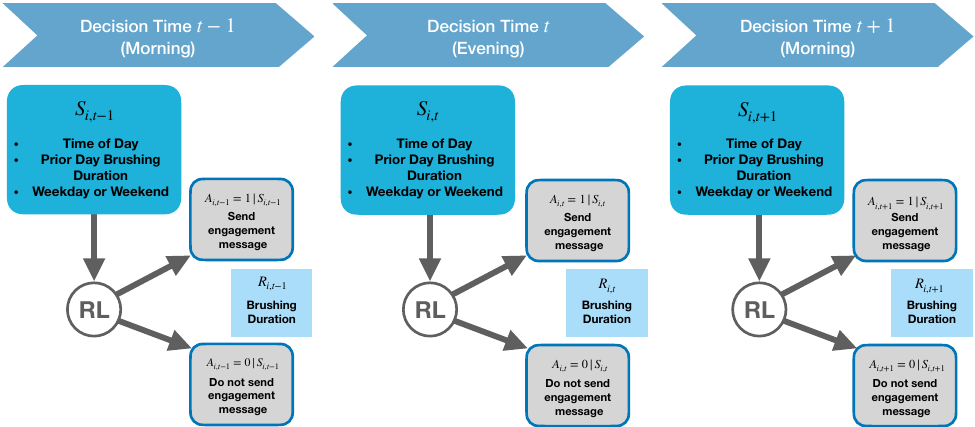
Figure 1. Decision times and actions for the RL algorithm in the Oralytics study. There will be two decision times per day (one in the morning and one in the evening); in total, each user will have 140 decision times, which we index by t . At a given decision time t , the RL algorithm receives state information for each user S i , t (this will include information on whether it is a morning or evening decision time and whether it is a weekday or weekend, as well as information on the user’s previous day brushing). Given the state, the RL algorithm decides whether or not to send the user an engagement message (selects action A i , t ∈ { 0,1 } ). After an action is taken, the RL algorithm receives reward R i , t , which is the user’s subsequent brushing duration in seconds during the brushing window following the decision time. See Section 5 for a discussion on the challenges of designing an RL algorithm for